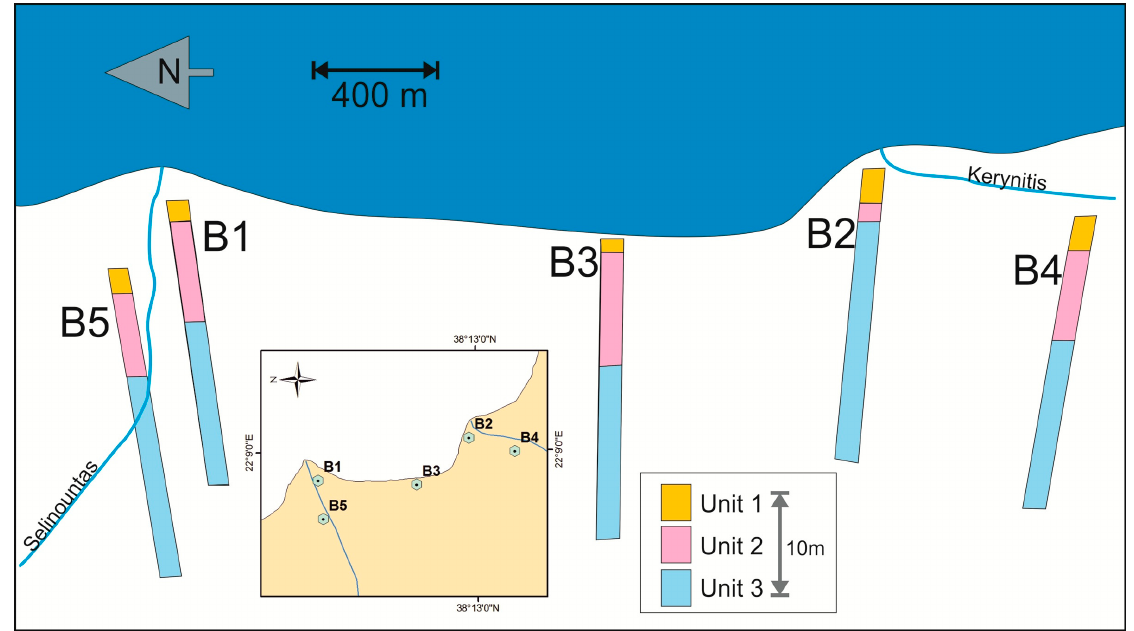
Figure 7. Three-dimensional representation of the three stratigraphic-geotechnical units recovered from the